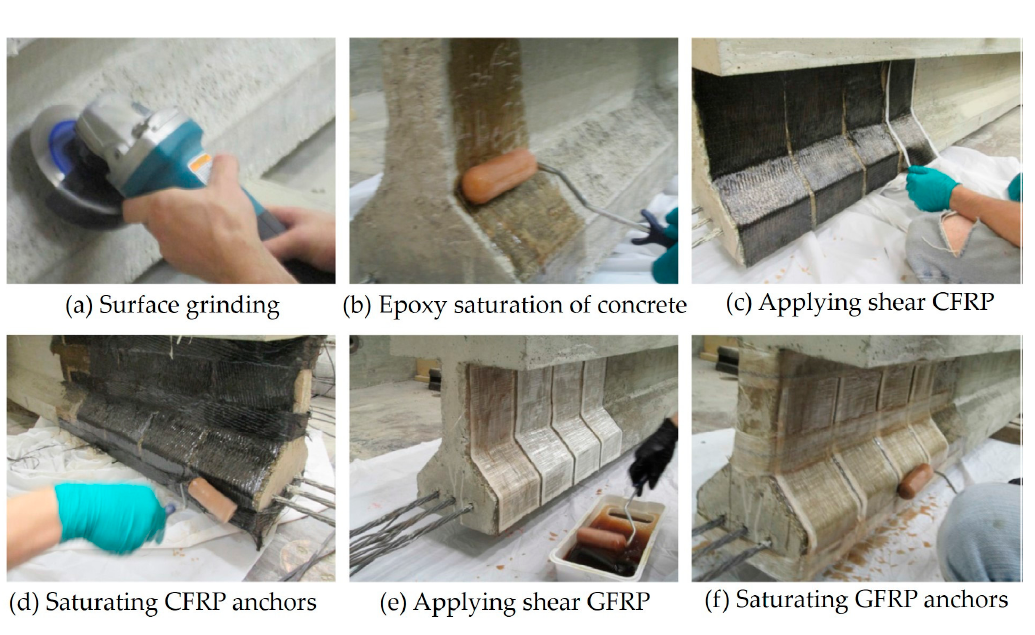
Figure 2. Example of application of CFRP (Carbon Fiber Reinforced Polymer) and GFRP (Glass Fiber Reinforced Polymer) by wet lay-up technique [7]. Reprinted from Construction and Building Materials, 148, Shaw I., Andrawes B., Repair of damaged end regions of PC beams using externally bonded FRP shear reinforcement, 184–194, Copyright (2017), with permission from